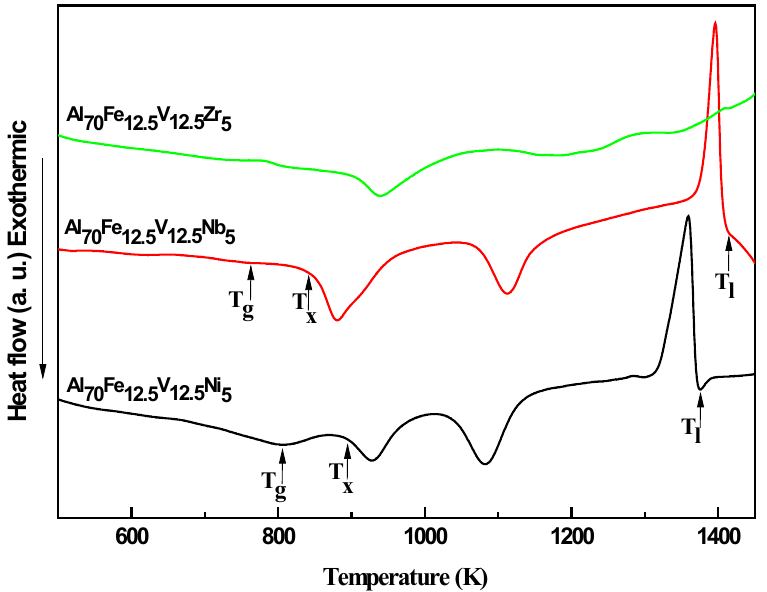
Figure 3. Differential scanning calorimetry (DSC) curves of the Al-Zr, Al-Nb and Al-Ni alloys at the heating rates of 20 K/min.